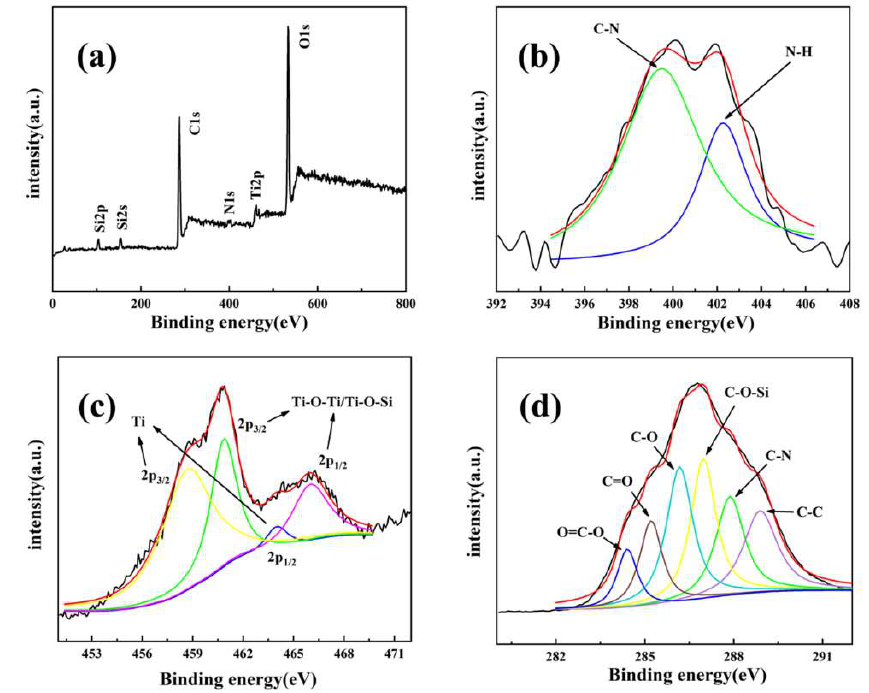
Figure 3. XPS spectra of GO-Ti: ( a ) Survey spectrum, ( b ) High-resolution spectra of N 1 s , ( c ) High-resolution spectra of Ti 2 p , ( d ) High-resolution spectra of C 1 s .